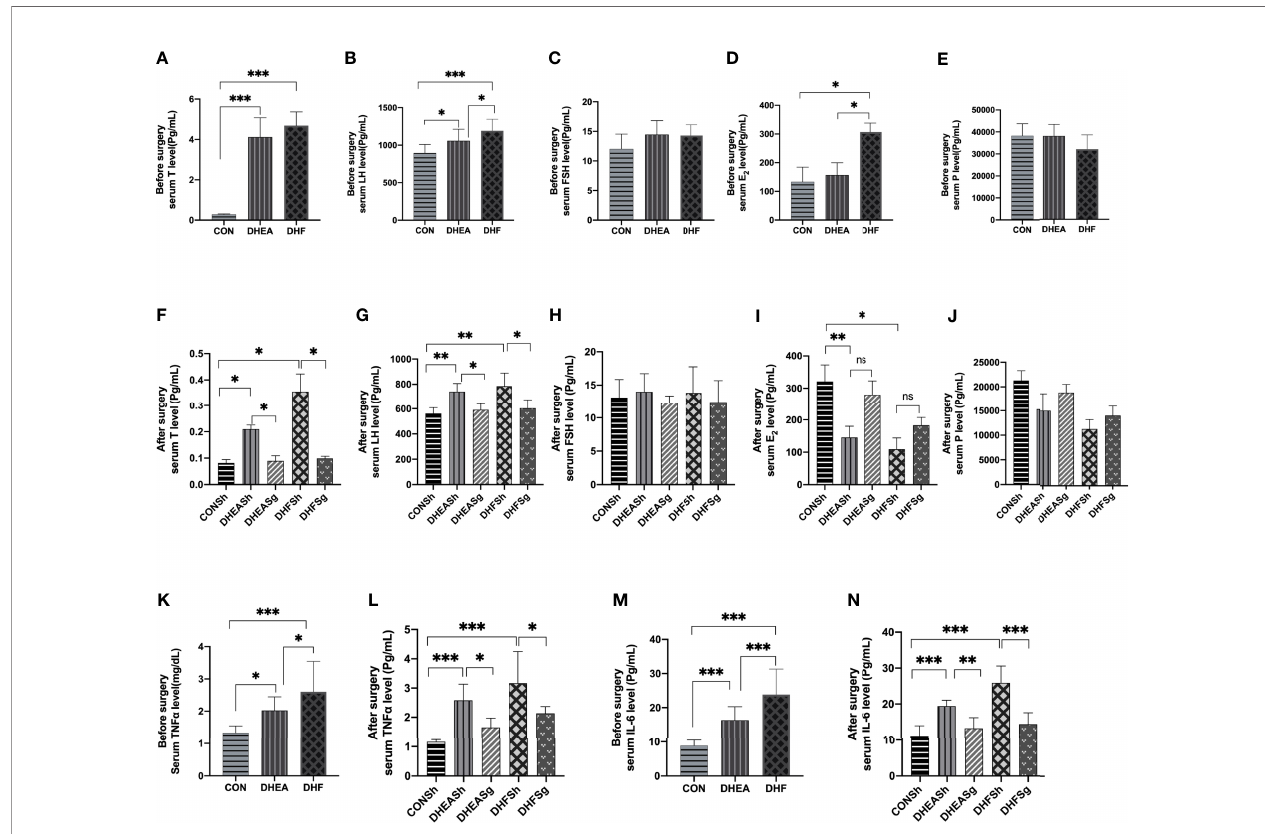
FIGURE 5 | | Effects of sleeve gastrectomy on the serum levels of steroid sex hormones and in fl ammatory factors. (A) total testosterone, (B) LH, (C) FSH, (D) E2, and (E) progesterone levels pre-surgery. (F) total testosterone, (G) LH, (H) FSH, (I) E2, and (J) progesterone levels post-surgery. (K) serum TNF a levels pre-surgery, (L) serum TNF a levels post-surgery, (M) serum IL-6 levels pre-surgery, (N) serum IL-6 levels post-surgery. LH: luteinizing hormone, FSH: follicle-stimulating hormone, E2: estradiol, TNF a : tumor necrosis factor alpha, IL-6: interleukin 6. *p < 0.05. **p < 0.01. ***p <